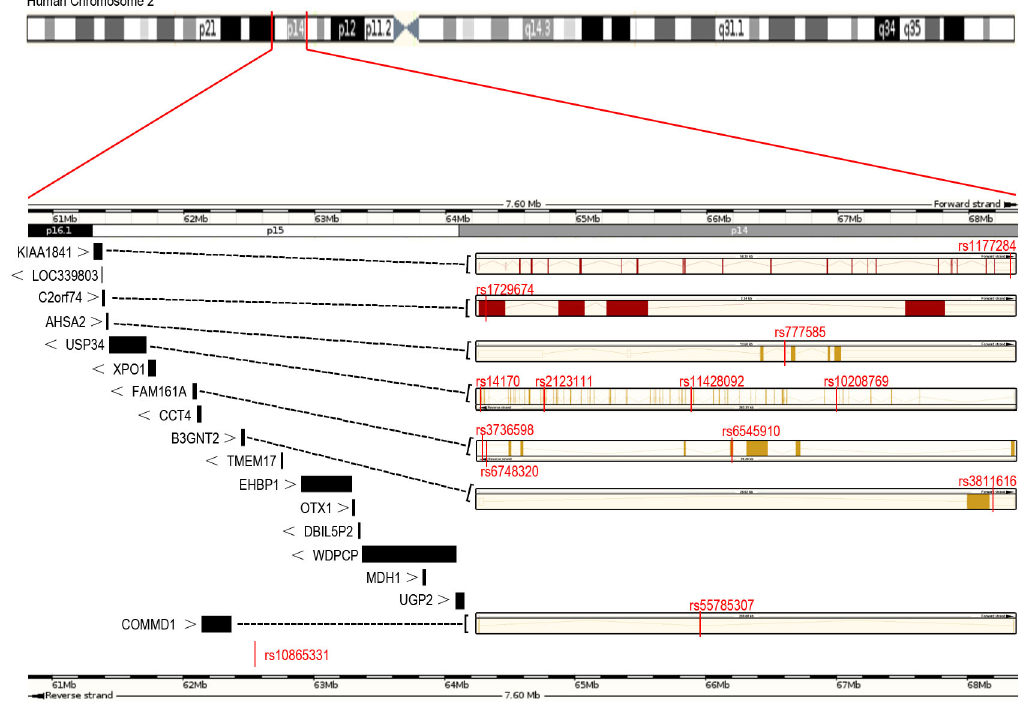
Fig 1. Schematic genomic structure on chromosome 2p15 region, and locations of the common single nucleotide polymorphisms (SNPs) identified in this study.